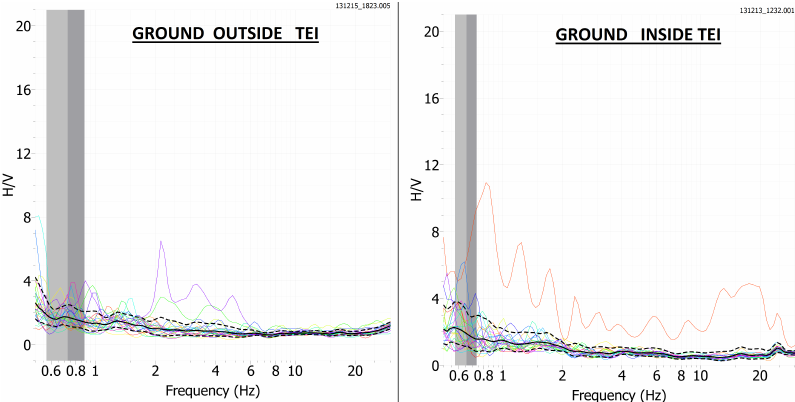
Figure 18. HVSR plots of outside area (left figure) and inside building of TEI on the lower floor (right figure).